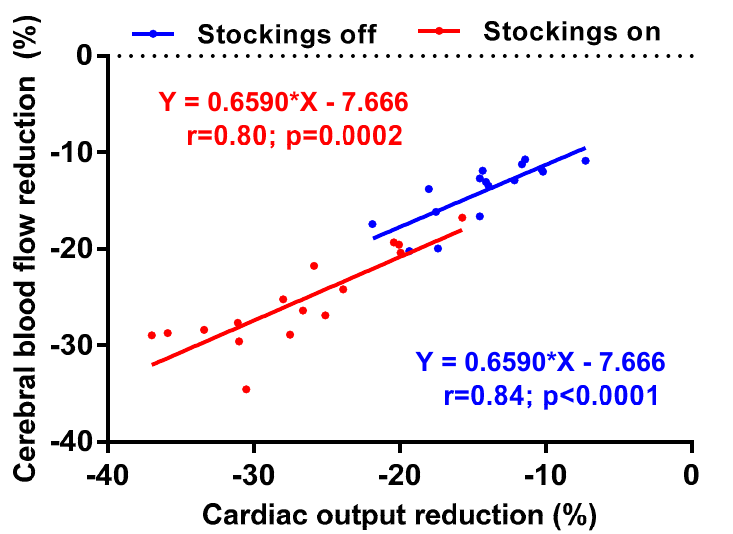
Figure 3. Correlation between the percent reduction in cardiac output and the percent reduction in cerebral blood flow with stockings off (blue) and stockings on (red). Figure 4 is an example of CO measurements supine (left panel), at end-tilt with stock- ings off (middle panel) and at end-tilt with stockings on (right panel). Figure 5 illustrates Legend Figure 4 CO: cardiac output (L/min). Images are suprasternal continuous wave Doppler echography showing time velocity integrals (VTI) and surface area is ex- pressed in centimeters. Legend Figure 5 LVA: left vertebral artery; RCA: right carotid artery. Images are pulsed wave Doppler echocardiography images of extracranial arteries. Traces are max velocity (outer lining) and mean velocity (second lining). The mean velocity is used to calculate the cerebral blood flow for the